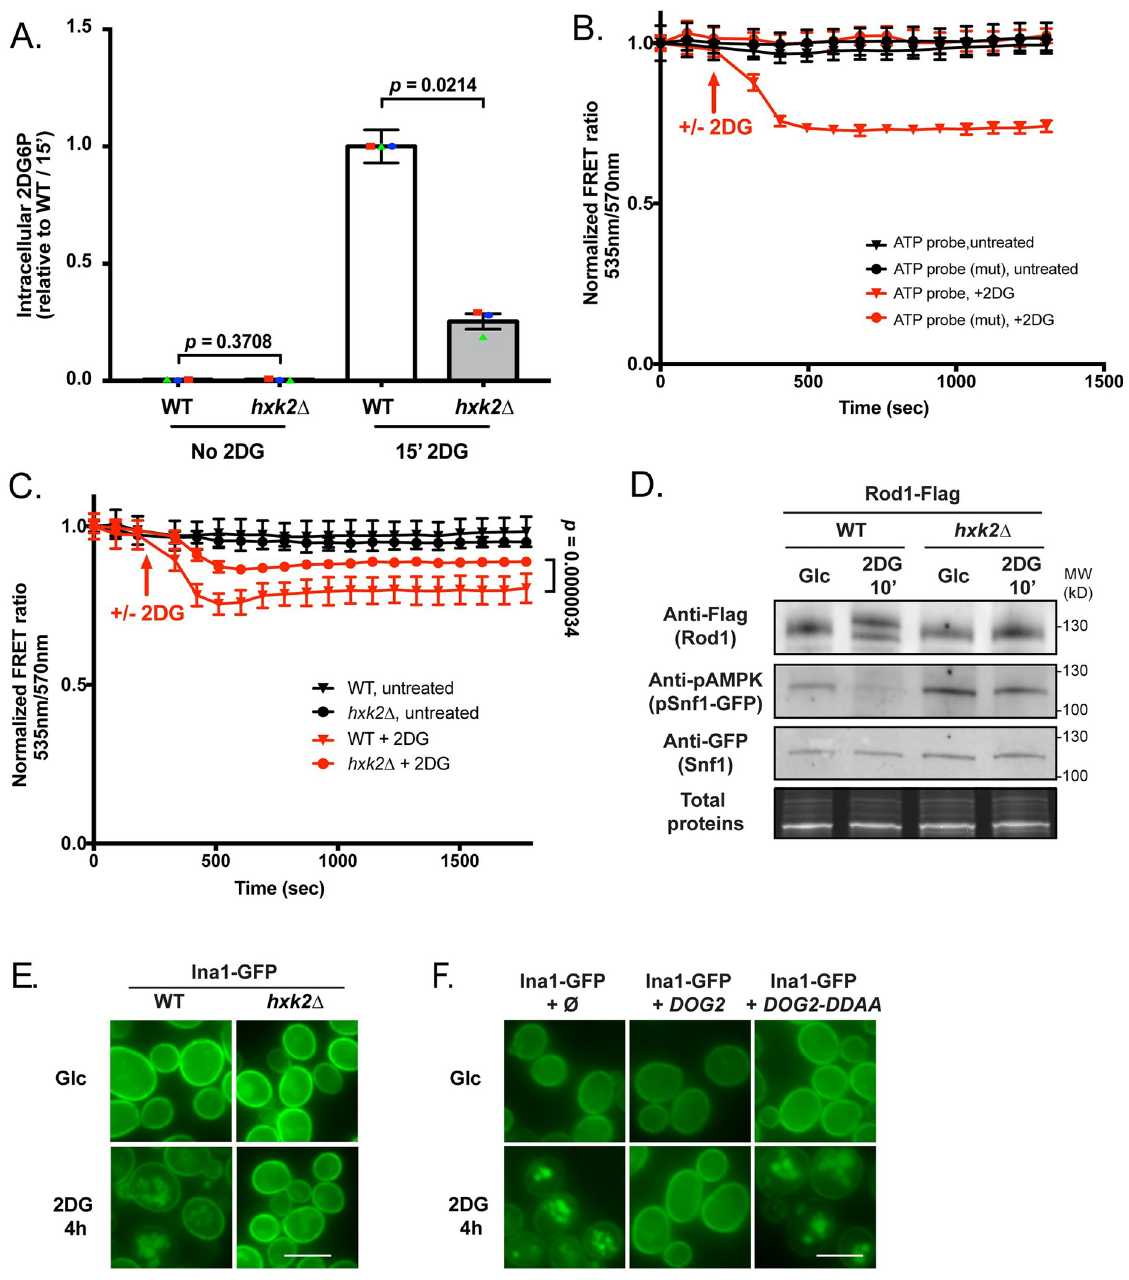
Fig 4. Hexokinase 2 (Hxk2) is the main 2DG-phosphorylating enzyme in vivo . ( A ) Intracellular 2DG6P was assayed enzymatically (see Methods) in WT and hxk2 Δ cells grown overnight in a glucose-containing medium and treated or not for 15 min with 0.2% 2DG. Values are normalized to the value of the WT / 15 min (n = 3 independent experiments ± SEM, p value indicated, paired t -test) ( B ) 2DG causes a decrease in ATP content as visualized using a FRET ATP biosensor. WT cells expressing the ATP biosensor (WT or mutated version) were grown overnight in a glucose-containing medium and treated with 0.2% 2DG (arrow). The FRET ratio (535/570 nm) was measured over time in a plate reader (see Methods) and is represented as normalized to the t0 value. ( n = 3 independent experiments ± SEM). ( C ) ATP levels were measured as in (B) in WT and hxk2 Δ cells in response to 2DG. The FRET ratio (535/570 nm) is represented as normalized to the t0 value (n = 4 independent experiments ± SEM). A paired t -test was used to compare WT + 2DG vs hxk2 Δ + 2DG ( p -value indicated). ( D ) Total protein extracts of WT and hxk2 Δ expressing Snf1-GFP and Rod1-Flag were prepared before and after 10’ 2DG treatment and immunoblotted using anti-Flag, anti-phospho-AMPK and anti-GFP antibodies. ( E ) WT or hxk2 Δ cells expressing Ina1-GFP were grown in a glucose-containing medium and observed by fluorescence microscopy before and after 2DG treatment for 4h. Scale bar, 5 μ m. ( F ) WT cells expressing Ina1-GFP and transformed with an empty plasmid, or with plasmids allowing the overexpression of DOG2 or its catalytic mutant DOG2-DDAA were grown in a glucose-containing medium and observed by fluorescence microscopy before and after 2DG treatment for 4h. Scale bar, 5 μ m.